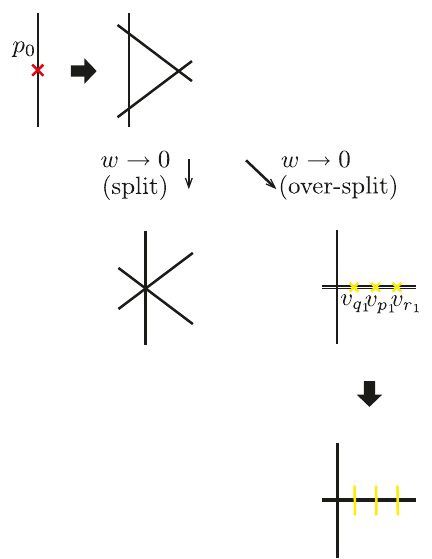
Figure 3 . Singularities and exceptional curves in a split and an over-split I 3